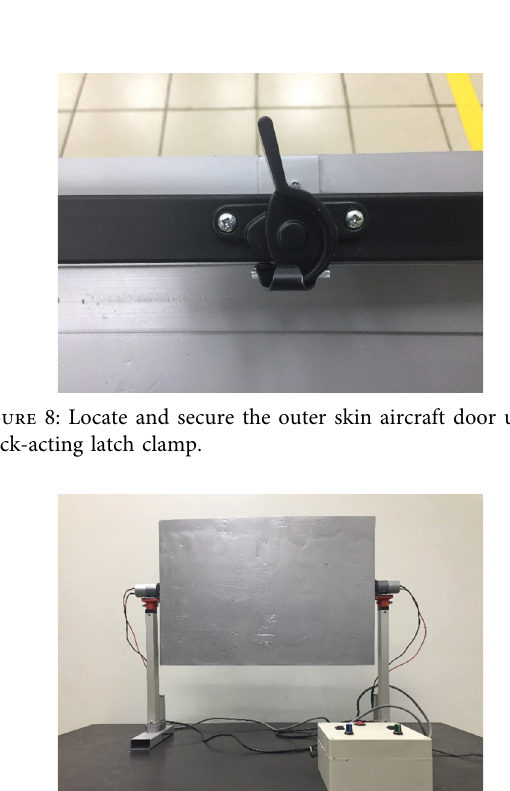
Figure 7: Position the outer skin aircraft door on the top of the